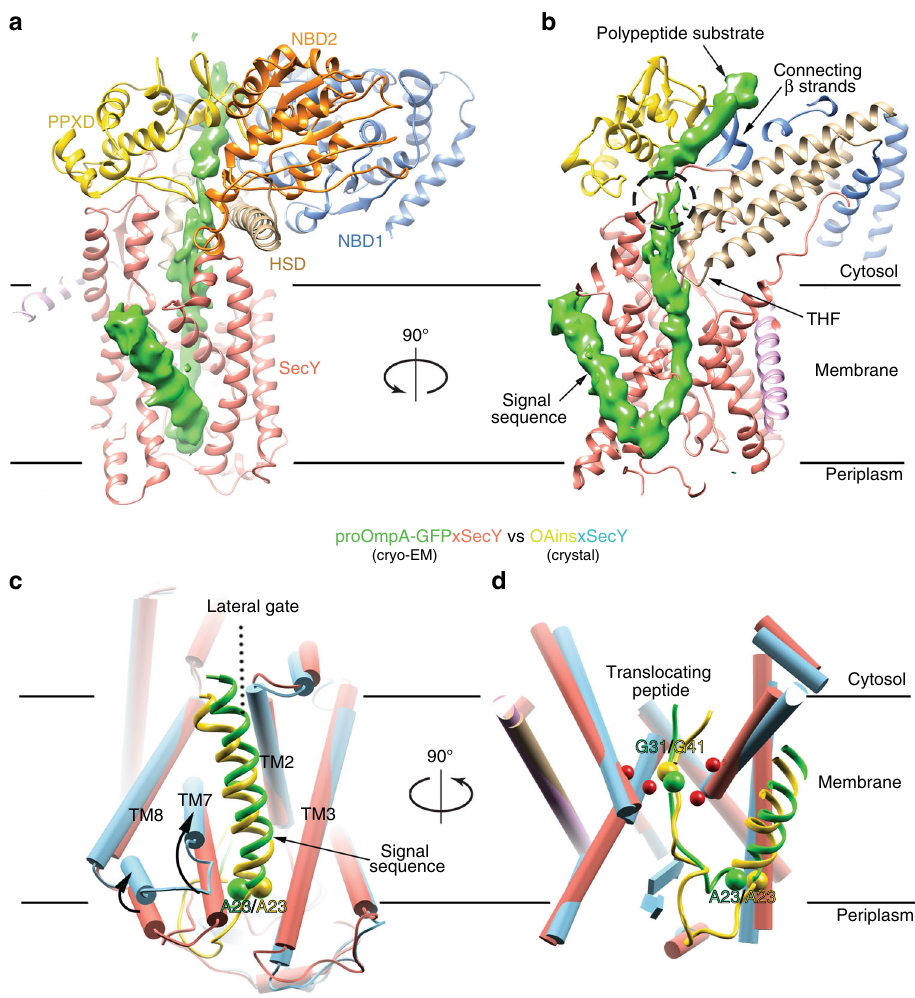
Fig. 3 The translocating polypeptide in the SecA-SecY complex. a Density for the polypeptide (green) is shown in a ribbon diagram of the translocation complex. SecA domains are shown in different colors. b As in ( a ), but a cut-away view from a different angle. The dashed circle indicates a region where the substrate could not be traced, likely because it is fl exible. c Comparison of the signal sequences and lateral gates between the cryo-EM and crystal (PDB ID: 5EUL) structures. SecY is shown as cylinders in salmon and cyan, respectively. The signal sequences are shown as ribbon diagrams, colored green and yellow for the cryo-EM and crystal structures, respectively. The movements of TM7 and TM8 are indicated by arrows. d As in ( c ), but cut-away side view from a different angle. The fi rst residue after the signal sequence (Ala23) and the Gly residues trapped inside the pore rings (red balls) are labeled and shown as